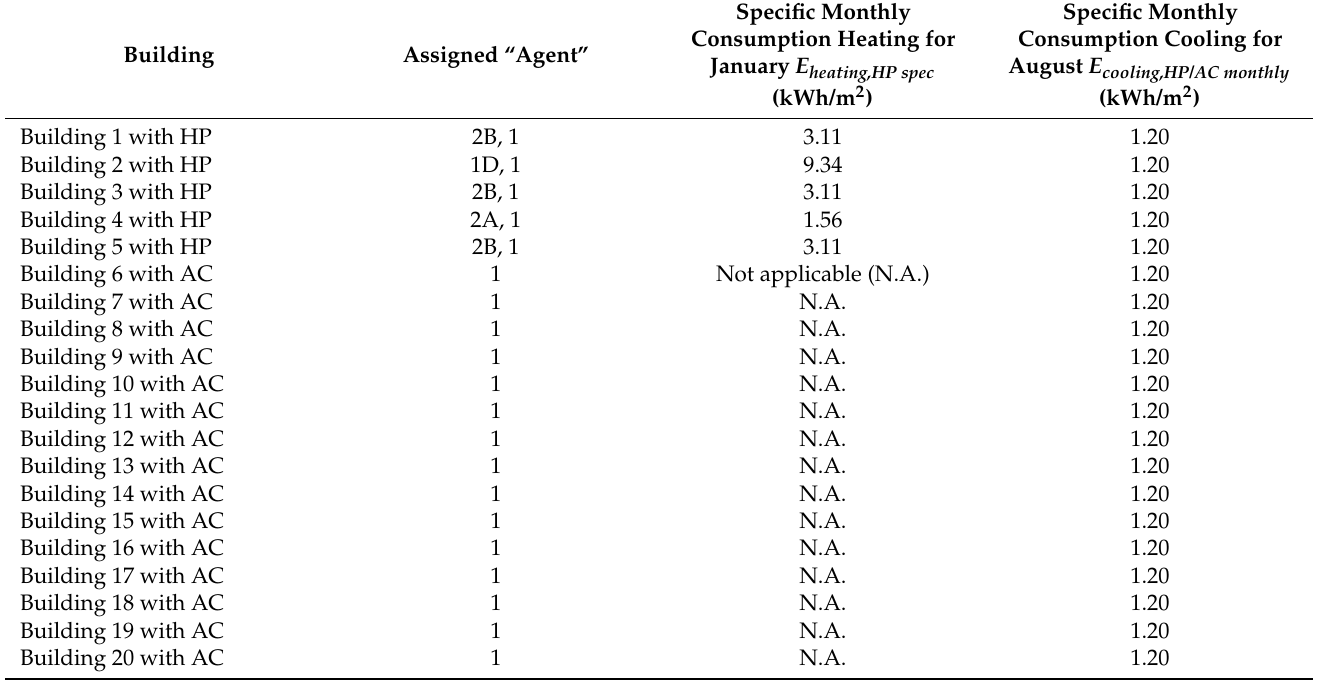
Table 2. Summary of the case study data sources—example for specific heating and cooling electrical energy demands for two months.